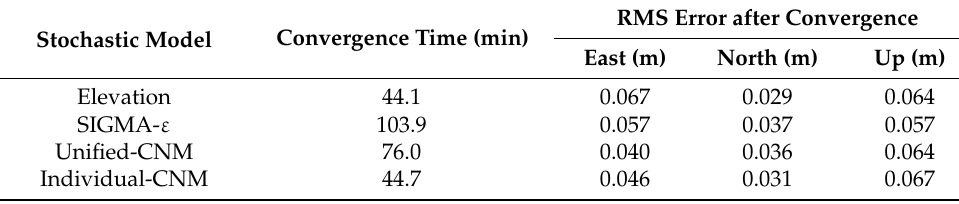
Table 4. Real-time differential RMS errors of different stochastic models for positioning.